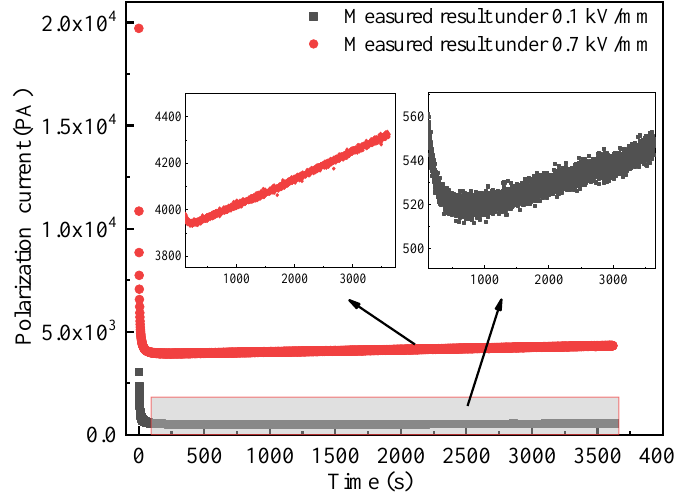
Figure 6. Current TDS of MgO powder at 25 °C.